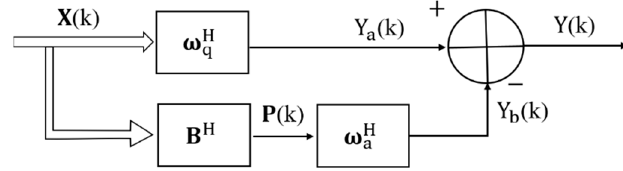
Figure 1. Structure of generalized sidelobe canceler.